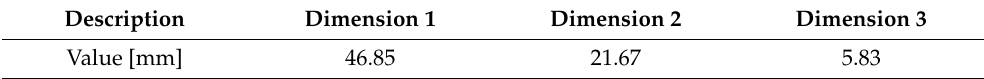
Figure 13. Deflection for the open lever with 0.2% shrinkage-rate constant applied. Table 22. Results of measurement 1, 2, 3 for the open lever with 0.2% shrinkage-rate constant applied.